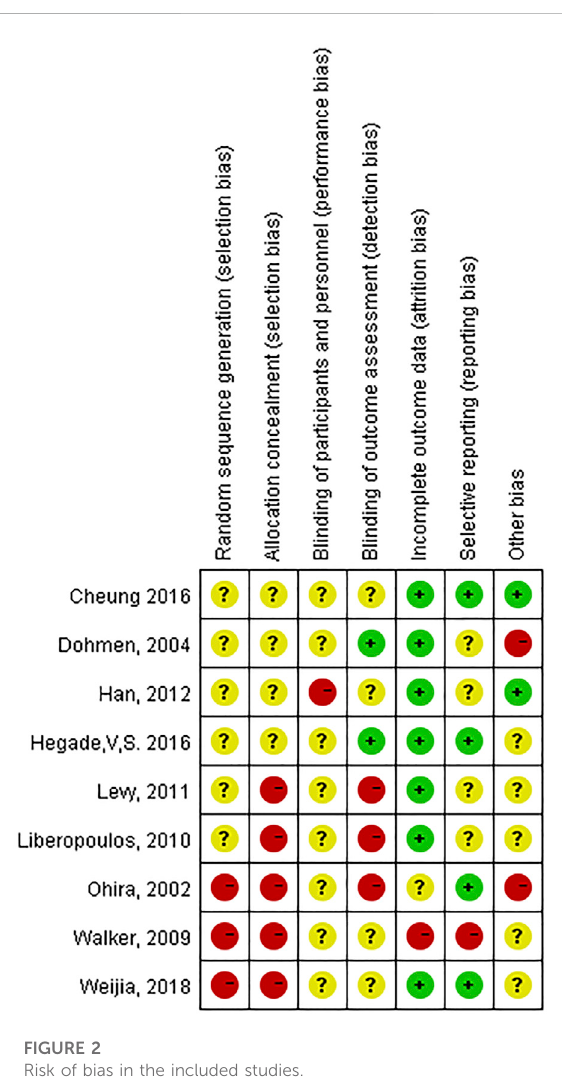
FIGURE 2 Risk of bias in the included studies.